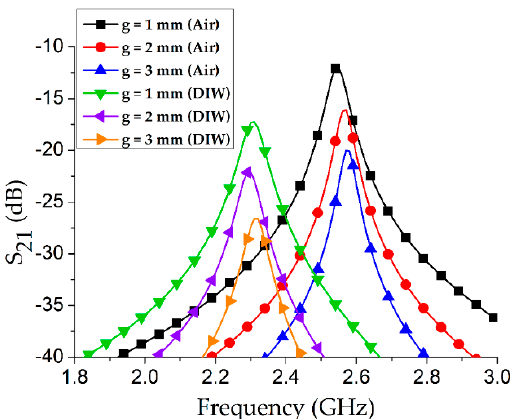
Figure 5. Investigation of optimum coupling gap ( g ) based on the criterion of maximum frequency shift ( Δ f ) corresponding to dielectric properties of air and deionized water (DIW). The optimum coupling gap is found as g = 2 mm because at this coupling the higher frequency shift ( Δ f = 270 MHz) as compared to other two cases of g = 1 mm and 3 mm, is achieved.